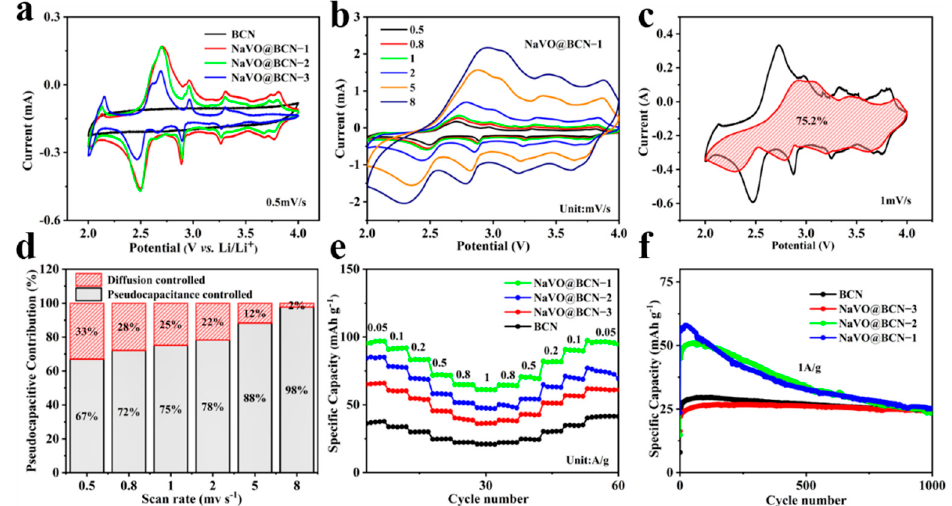
Figure 3. Electrochemical performance of all the samples: ( a ) CV curves of the NaVO@BCN and BCN nanotubes; ( b ) CV curves of the NaVO@BCN-1; ( c ) tThe capacitive contribution (red region) and the total contribution (black line); ( d ) contribution ratio of the capacitive process and the diffusion-controlled Faradaic process of the NaVO@BCN-1; ( e ) the rate performance of the BCN nanotubes and NaVO@BCN; ( f ) cycling stability of the BCN nanotubes and NaVO@BCN at 1 A g − 1 .